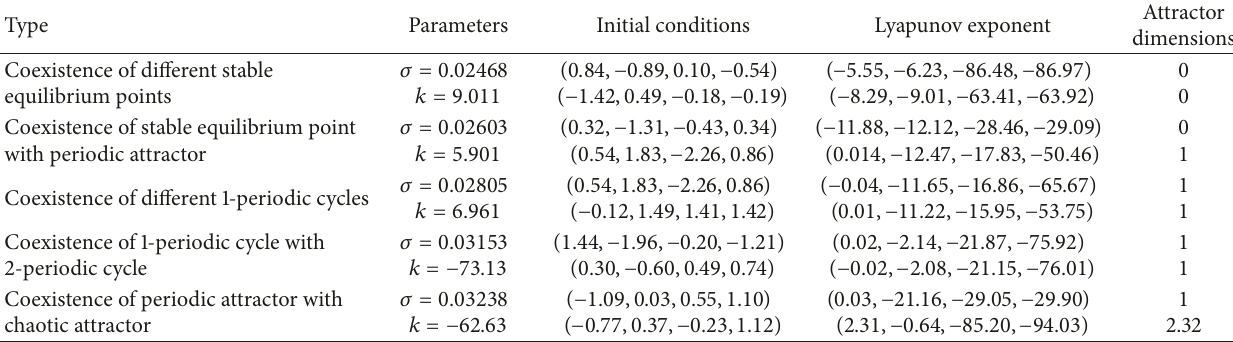
Table 2: Coexisting attractors at different combinations of